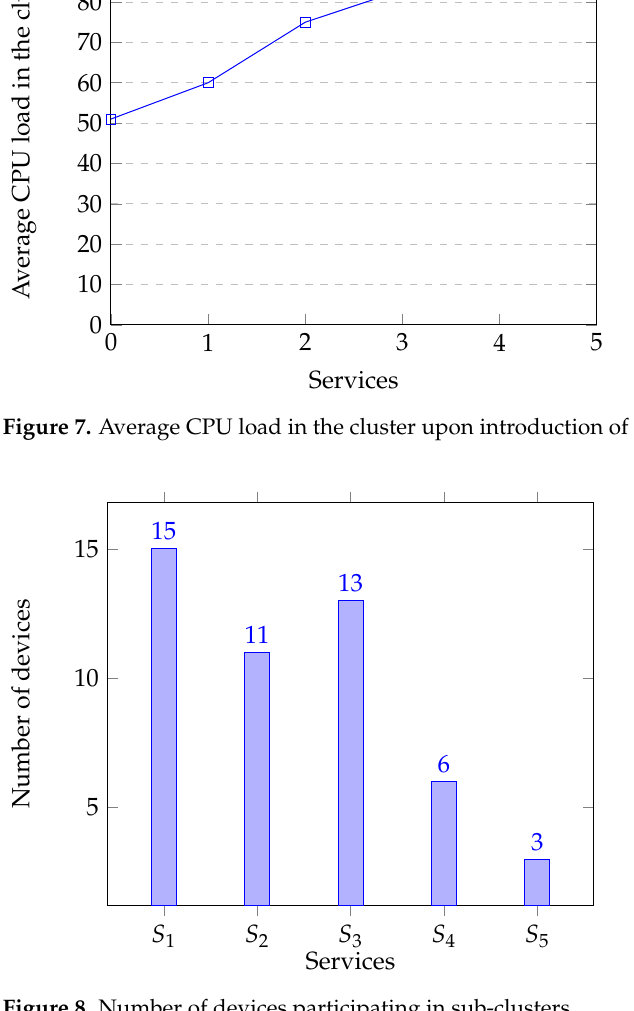
Figure 8. Number of devices participating in